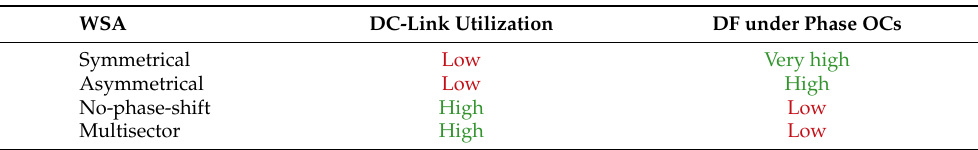
Table 18. In broad terms, performance for different stator WSAs (Section 4.1.2) in multiphase applications in the literature [20,234,265,266,268,305,329]. WSA DC-Link